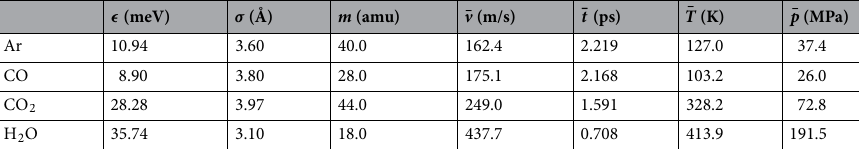
Table 2. LJ parameters, ǫ and σ , and mass, m , of the four materials: Ar, CO, CO 2 , and water. LJ units √ √ ǫ/ m , time ¯ t = σ m /ǫ , temperature, T = ǫ/ k B , and pressure, ¯ p = ǫ/σ 3 , where k B is for velocity, ¯ v = Boltzmann’s